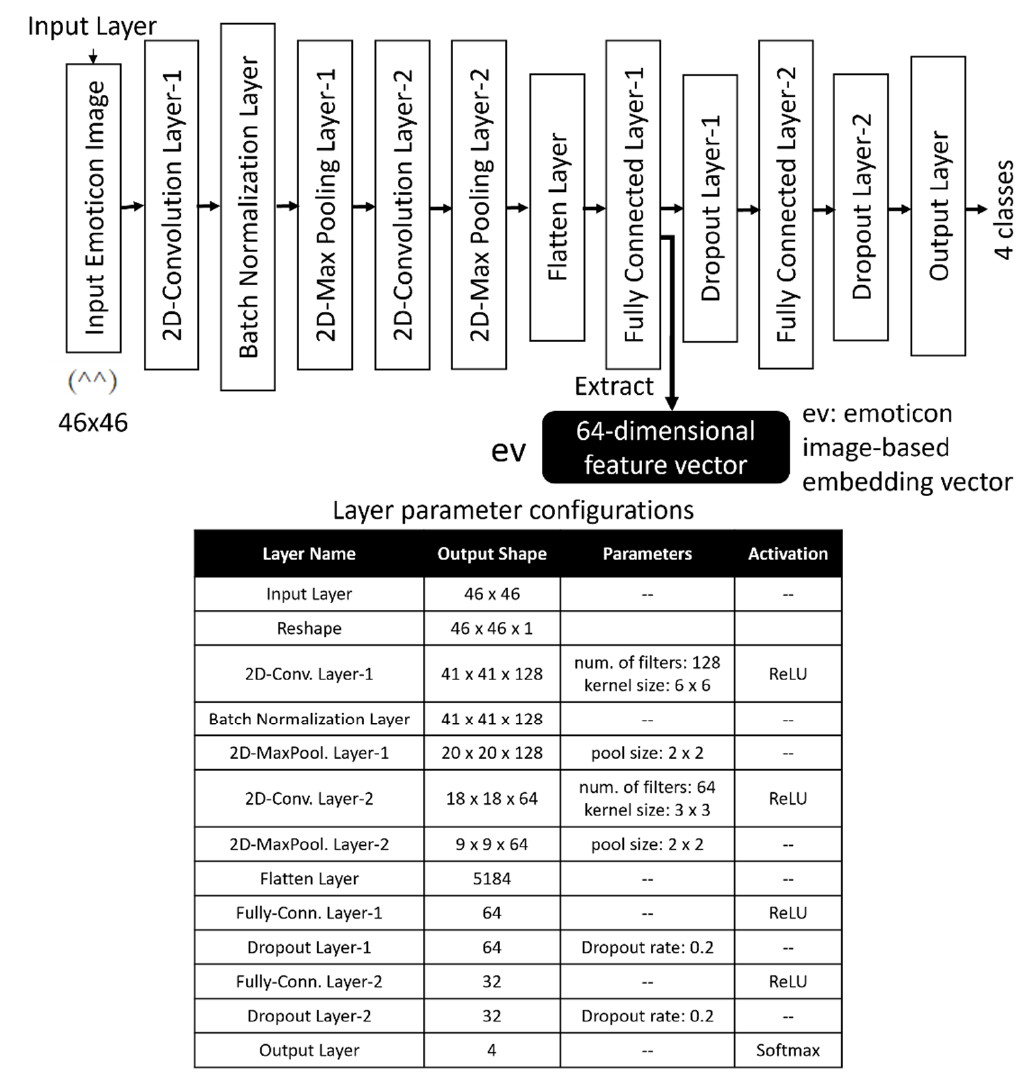
Figure 2. Deep convolutional neural networks employed for emotion estimation from emoticons.